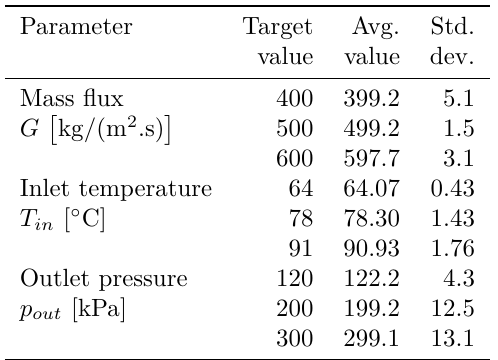
Table 3. Experimental parameters with deviations